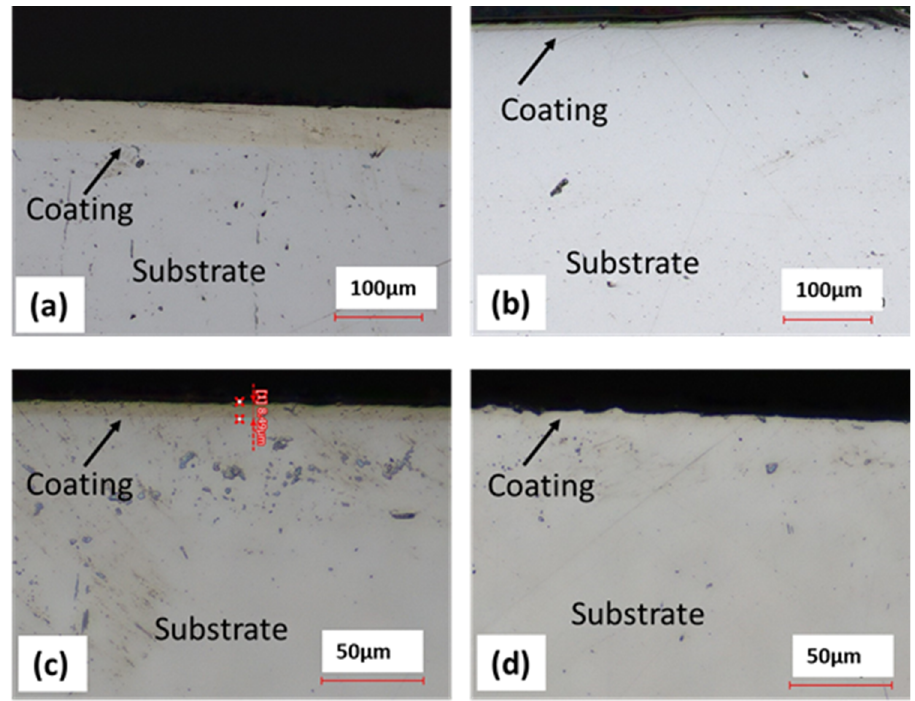
Figure 7. Micrographs of the Different Coatings’ Cross Sections: ( a ) 45 μ m Thick Ni-P Coating, ( b ) 9 μ m Thick Ni-P Coating, ( c ) 9 μ m Thick Ni-P-NiTi Coating, ( d ) 4 μ m Thick Ni-P-NiTi Coating. Wear tracks are categorized by coating type, indenter shape, and the number of